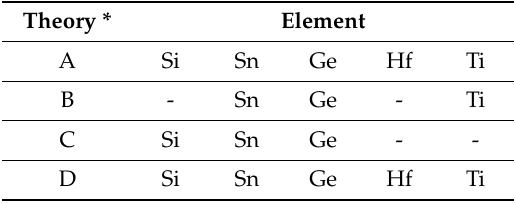
Table 6. Solutes in Nb-X binary alloys predicted to segregate to the surface. Theory